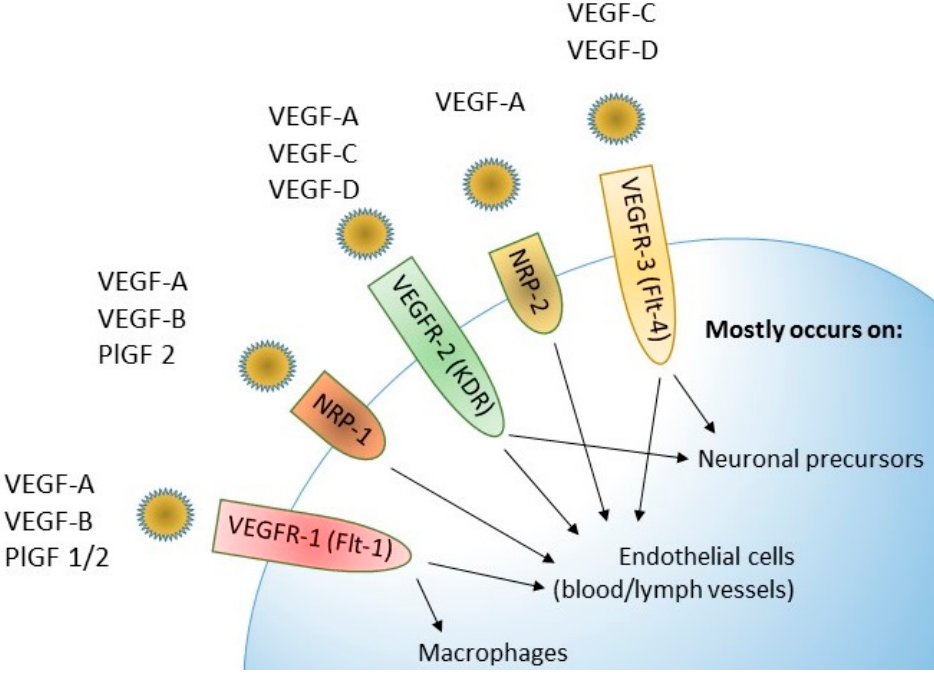
Figure 4. Possible bindings between VEGF family members ligands and receptors.